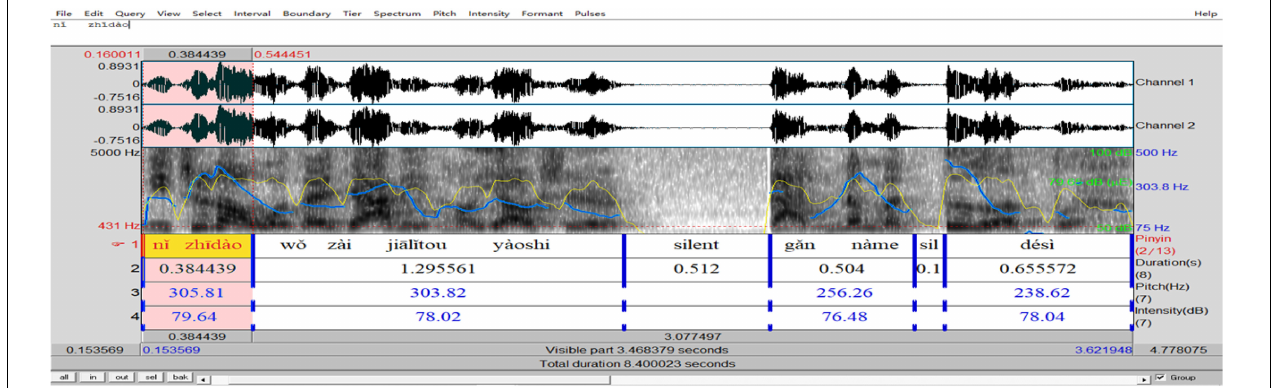
FIGURE 1 | Prosodic features of ni zhidao manifested through Praat.